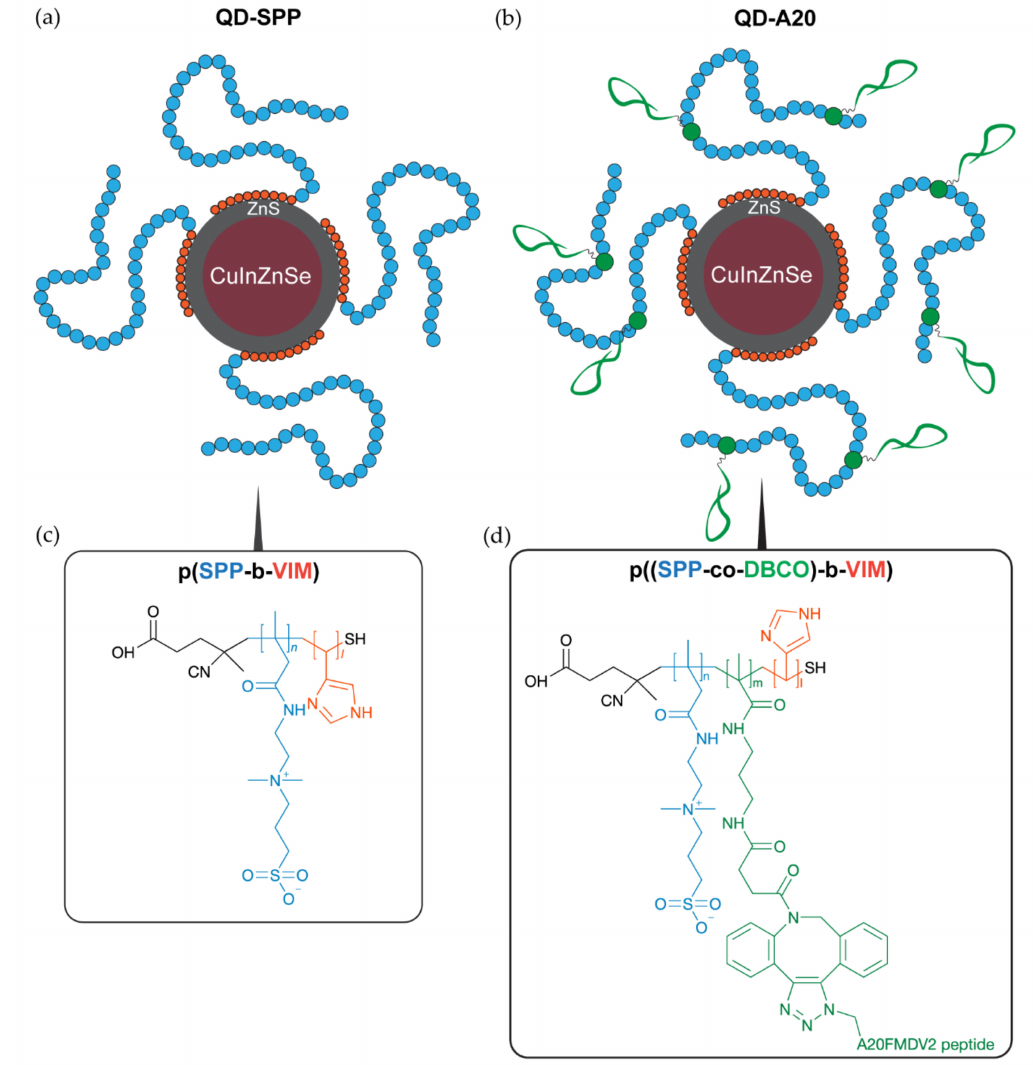
Figure 1. Schematics of ZnCuInSe / ZnS quantum dot (QD) structure: ( a ) Control QDs (QD-SPP) and ( b ) targeted QD-A20. ( c , d ) Schematics of the QD-A20 surface chemistry. Control QDs (QD-SPP) were coated with pure ( c ) p(SPP-b-VIM) block polymers, while ( d ) the p((SPP-co-APMA)-b-VIM) polymeric ligand was reacted with DBCO-NHS and with the α v β 6 -targeting peptide N 3 -A20 in QD-A20. The indicated degree of polymerization: sulfobetaine (SPP, blue, solubilization and antifouling, n ≈ 35), DBCO (green, functionalization, m ≈ 5) and imidazole (orange, anchoring, l ≈